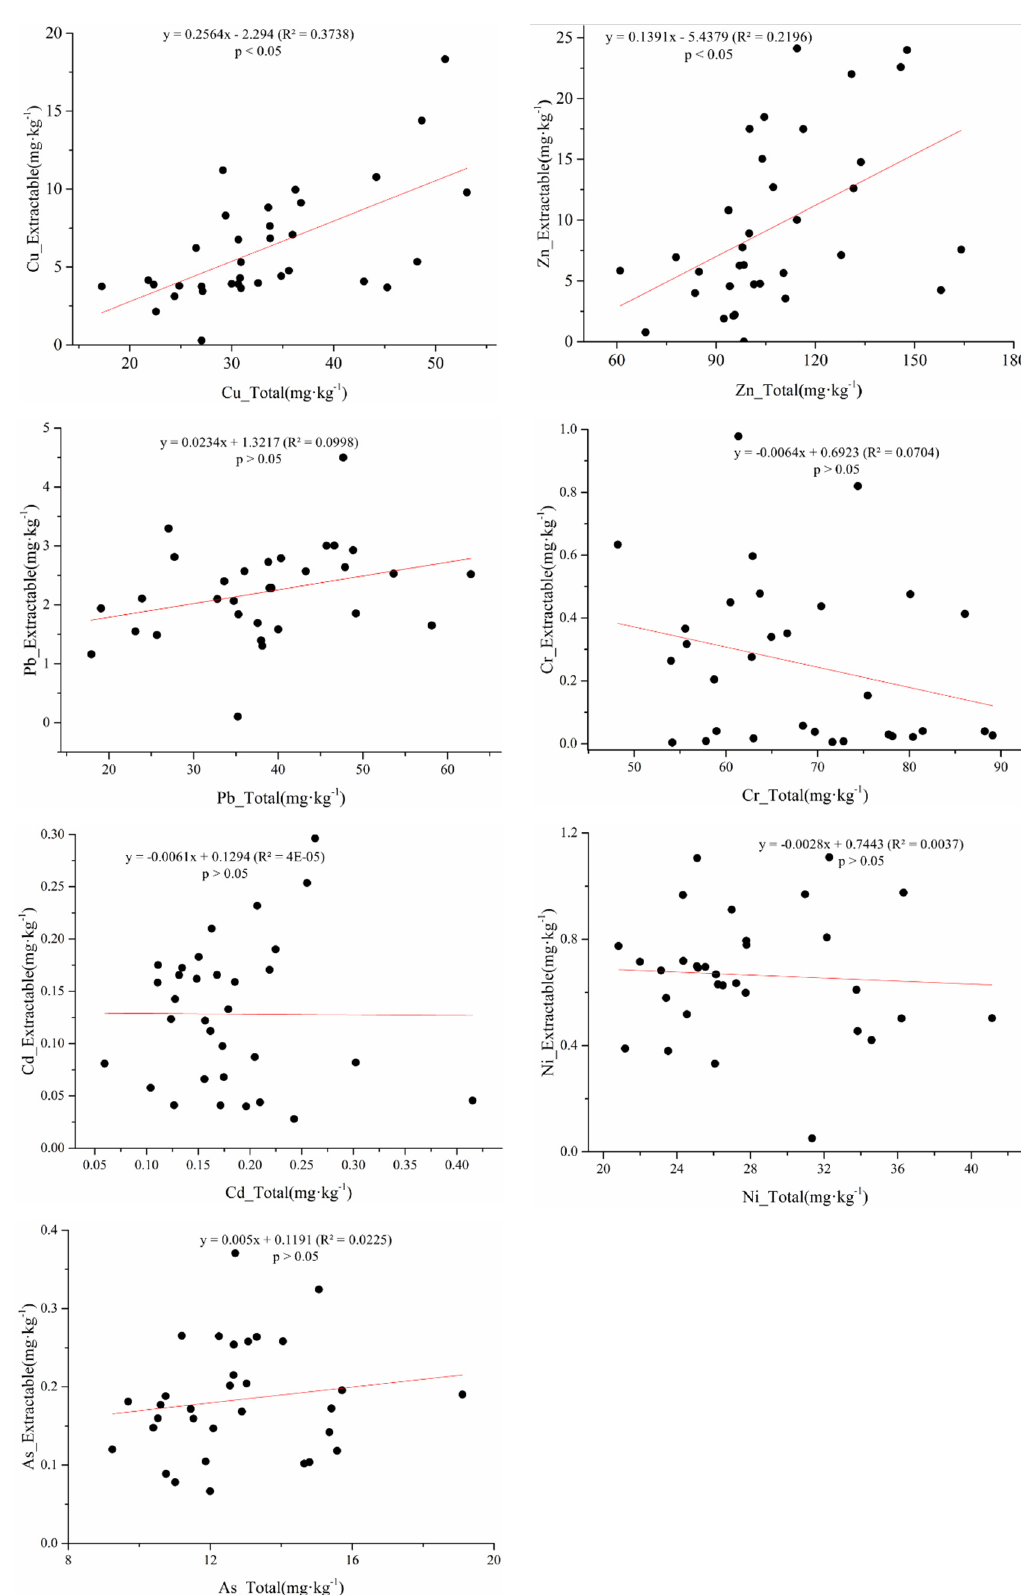
Figure 4. The available metal content (mg·kg − 1 ) versus the total metal content (mg·kg − 1 ) in soils. Available Cr, Pb, Ni, Cd, and As were directly correlated with the SOM content (Figure 5), demonstrating that the logarithm of DTPA-extractable metals (Pb, Cr, Mn, or